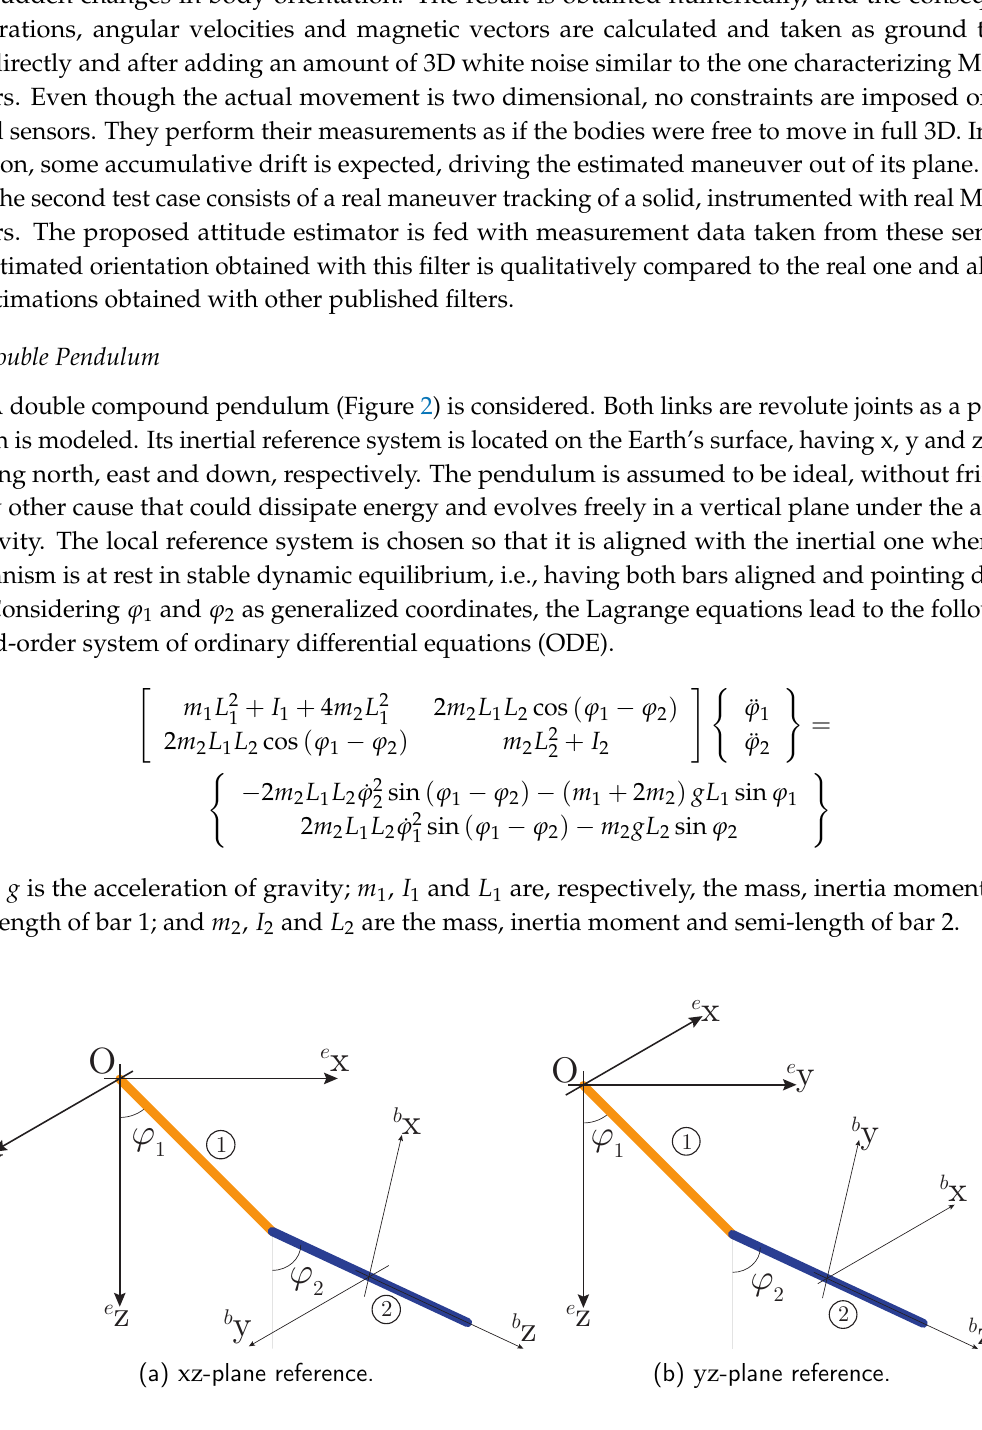
Figure 2. Reference systems for the double pendulum case